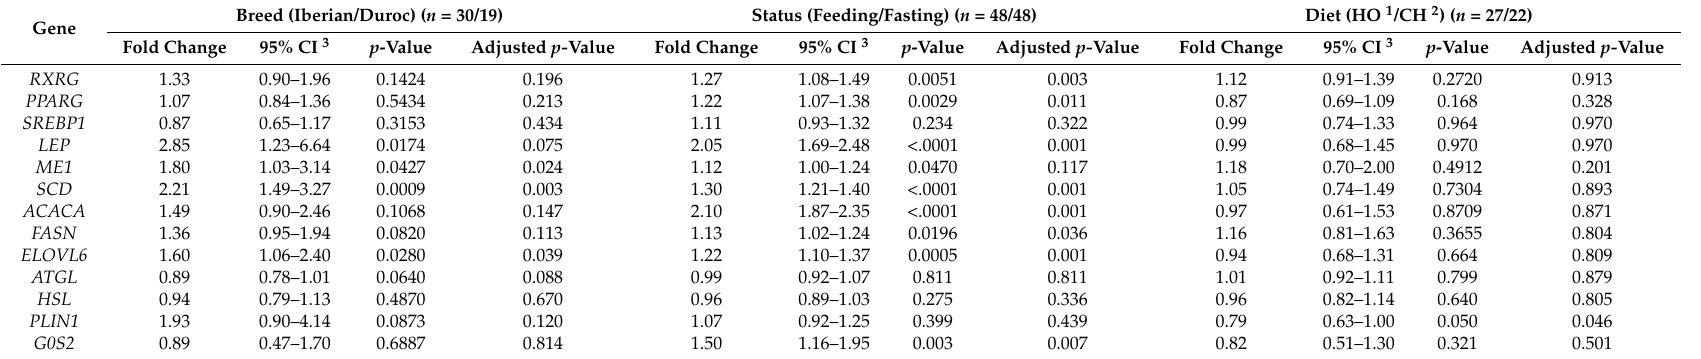
Table 3. Main effects of breed (Iberian/Duroc), feeding/fasting status and diet (HO/CH) on expression of candidate genes in ham adipose tissue. Breed (Iberian/Duroc) ( n = 30/19) Status (Feeding/Fasting) ( n = 48/48) Diet (HO 1 /CH 2 ) ( n = Gene